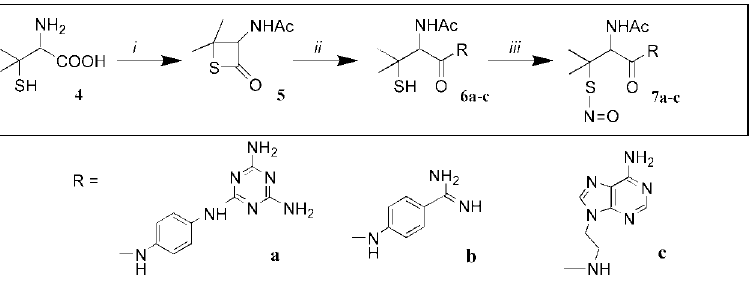
Figure 2 - Synthesis of compounds 5, 6 and 7. The reaction conditions were: i , acetic anhydride; pyridine (0 o C for 30 min, and then at room temperature (RT for 15 h). ii , 7a: 8, DMF (RT for 20 h). 7b: 4-aminobenzamidine, NaOH 1 M; chloroform (RT for 2 h). iii , 7c: 9, NaOH 1 M; chloroform (RT for 2 h).